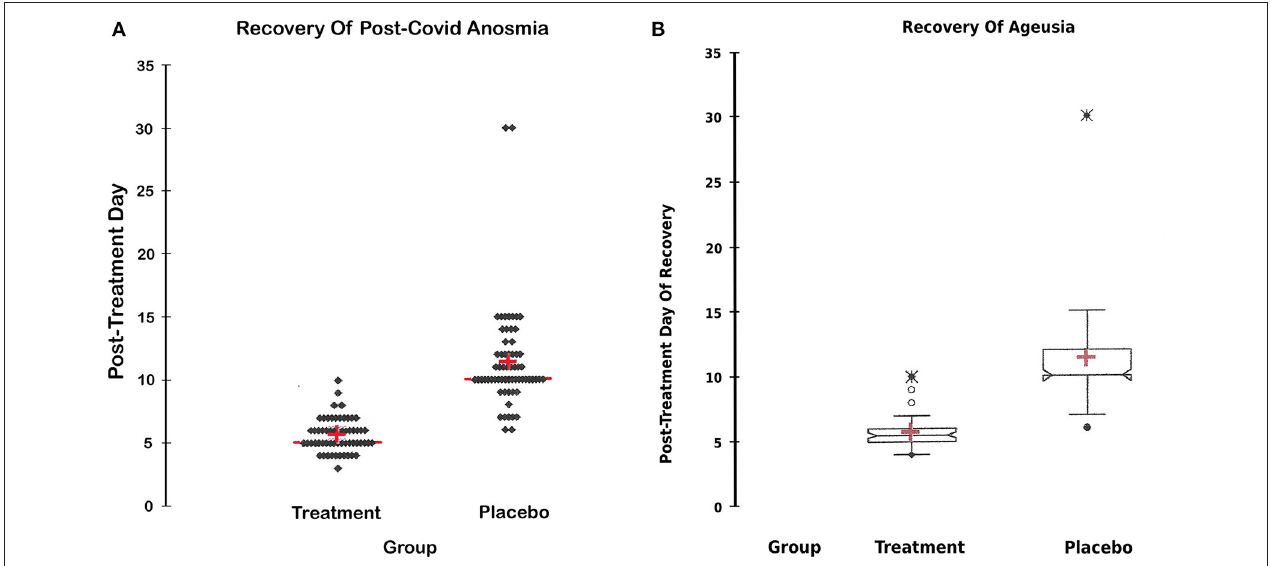
FIGURE 4 | (A) Recovery of anosmia. (A) Day of the return of smell in both groups; the day of complete recovery of lost smell after commencement of treatment in both groups. A statistical figure (scattergram) where the cross represents the mean, the transverse red line represents the median, the upper and lower dots represent the minimum and maximum, and each dot represents a patient recovery timing. The treatment restored lost smell significantly earlier than the placebo group CI around the mean [4.6:6.9], P -value < 0.0001. (B) Recovery of Ageusia. (B) Day of the return of taste in both groups; the day of complete recovery of lost taste sensation after commencement of treatment in both groups. A statistical figure where the cross represents the mean, the upper and lower dots represent the minimum and maximum, and the notches represent the confidence interval around the medium. The treatment restored lost smell significantly earlier than the placebo group, CI around the mean [4.4:6.9], P < 0.0001.